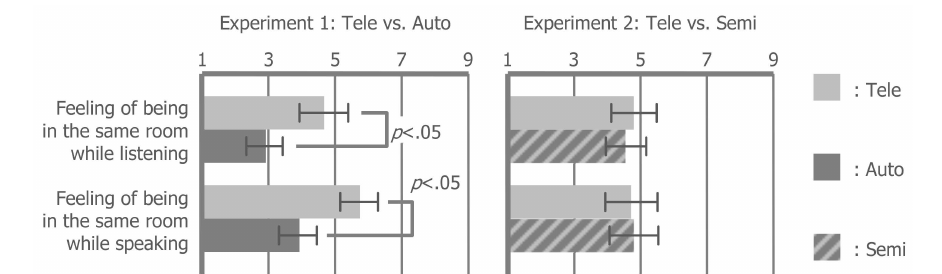
Figure 4. Results of measuring the sense of agency.